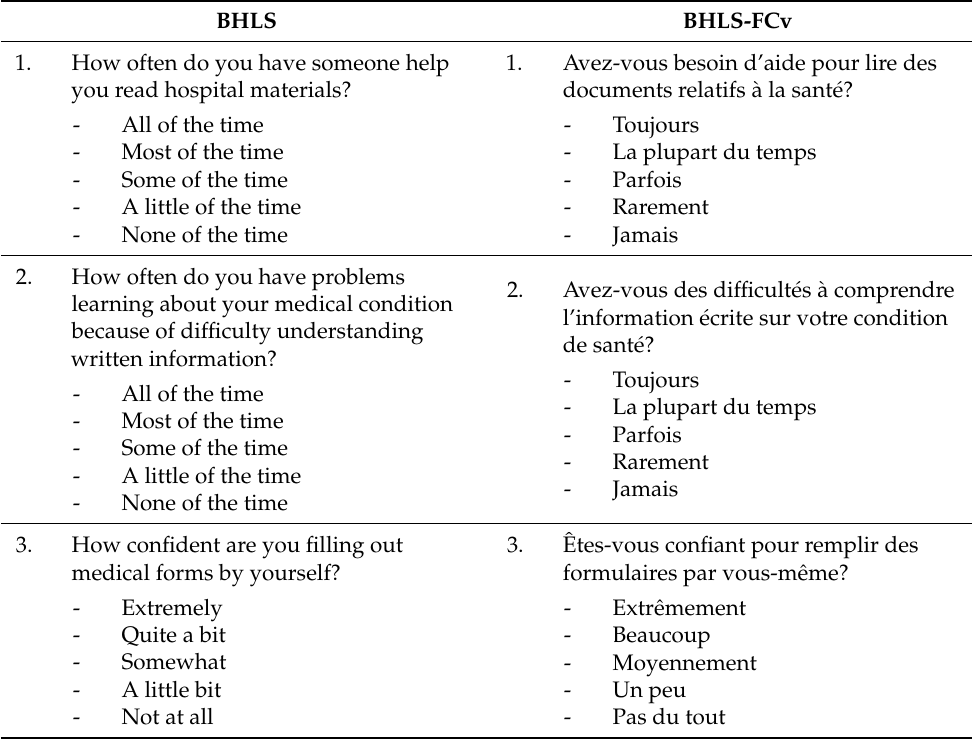
Table 2. English- and French-language versions of the